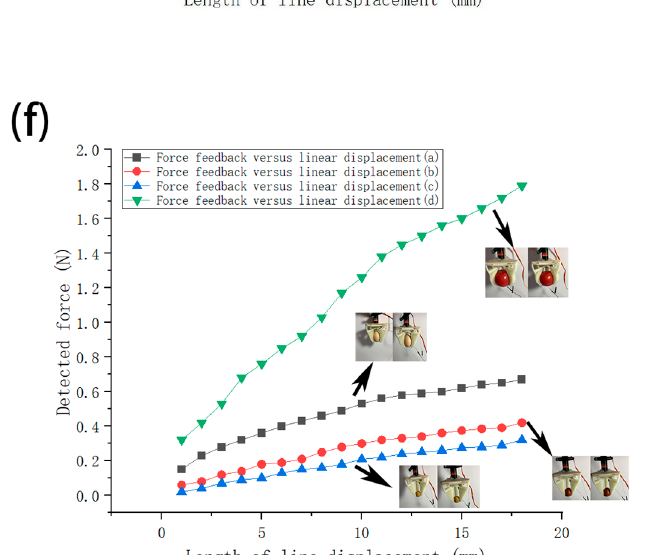
Figure 10. Examples of grasping objects ( a – d ). The graphs show examples of grasping postures of the force feedback gripper in grasping raw eggs ( a ), longans ( b ), dates ( c ), and tomatoes ( d ). ( e ) shows a graph of the variation in the degree of deformation of the pulling wire versus the end of the finger for the four sample experiments ( a – d ). ( f ) shows the variation of the pulling line versus force feedback for the four sample objects ( a – d ).